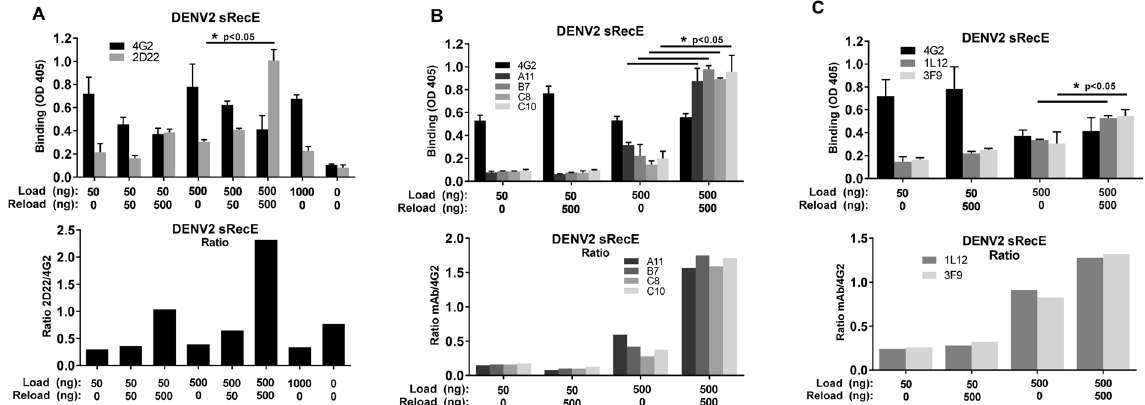
Figure 2. DENV2 sRecE dimer assembly on Ni 2 + -coated surfaces. ( A ) Indicated amounts of DENV2 sRecE were loaded and reloaded on Ni 2 + -coated plates and analyzed for monomeric (4G2) or dimeric protein structures (2D22). Increased dimer formation is displayed as the 2D22/4G2 signal ratio. ( B ) The same assay was performed with EDE1 (A11, B7), EDE2 (C8, C10) and C) 3F9 and 1M7 mAbs. No antibody signals were detected when no protein was loaded or reloaded and groups 500 + 0 and 500 + 500 were statistically compared by student T-test (p < 0.05).